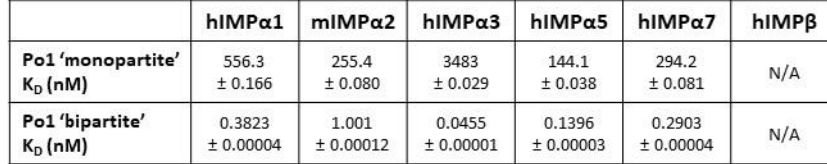
Figure 6. AAV Po1 Cap-BR demonstrates a greater binding affinity for importin isoforms than monopartite AAV Po1 Cap-NLS. ( A ) FP assay measuring the direct binding between the